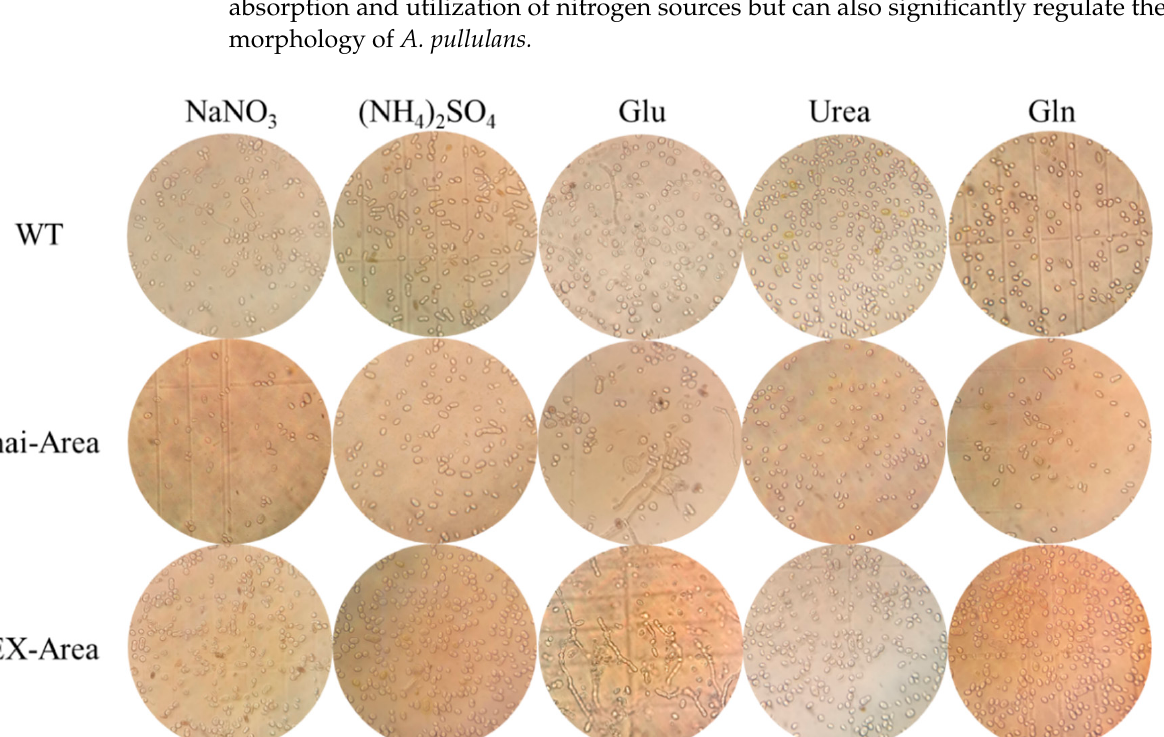
Figure 9. SEM of mutant strains culturing with different nitrogen sources. 3.9. Antioxidant Activity In Vitro of β -Glucan